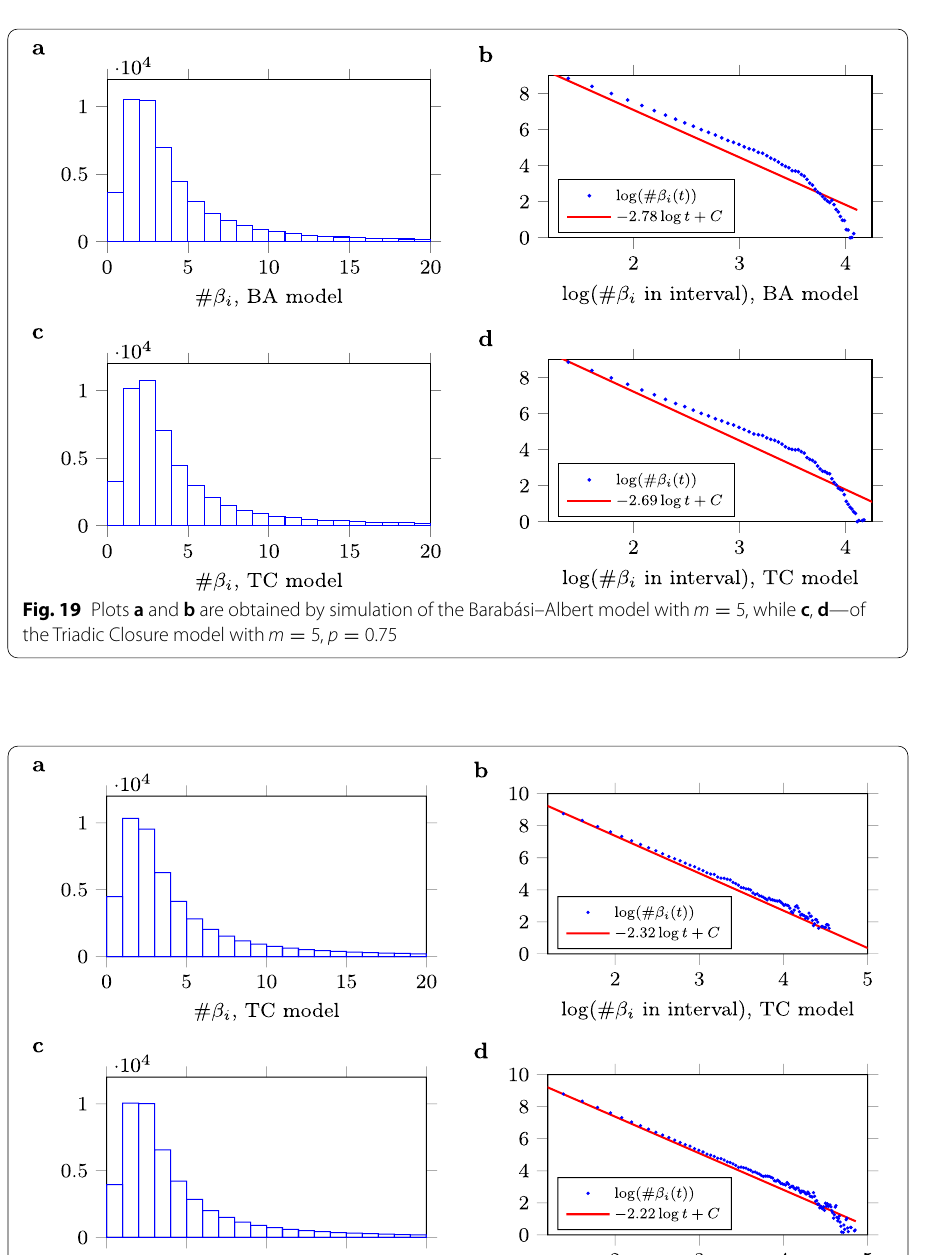
Table 6. In addition, the experiments show that by changing the parameters m (for BA model) and m , p (for TC model), it is possible to adjust the FI distributions of the gen- erated networks, although the general behaviour remains the same.